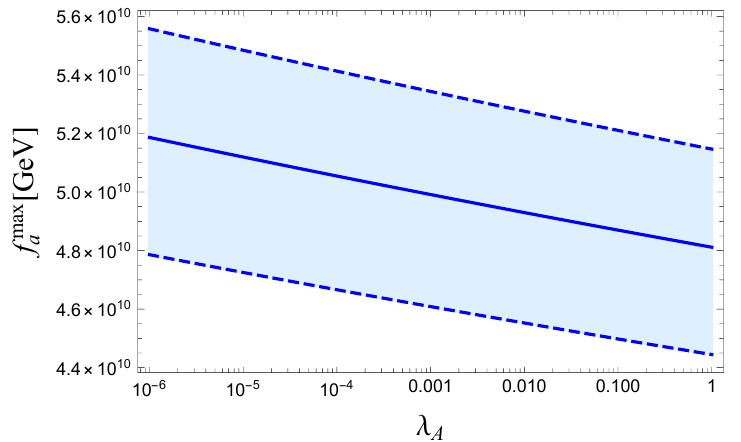
Figure 1. Dependence on λ A of the maximal value of f a obtained by requiring that DM is not overpro- duced in the a ν MSM. The width of the band corresponds to the uncertainties in Equations (6) and